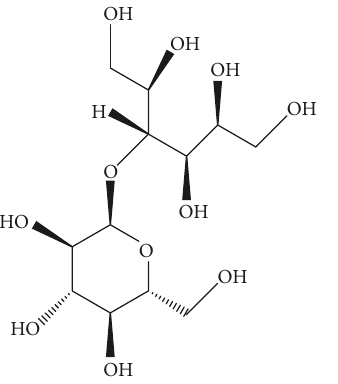
Figure 1: Chemical structure of maltitol (C 12 H 24 O 11 ).